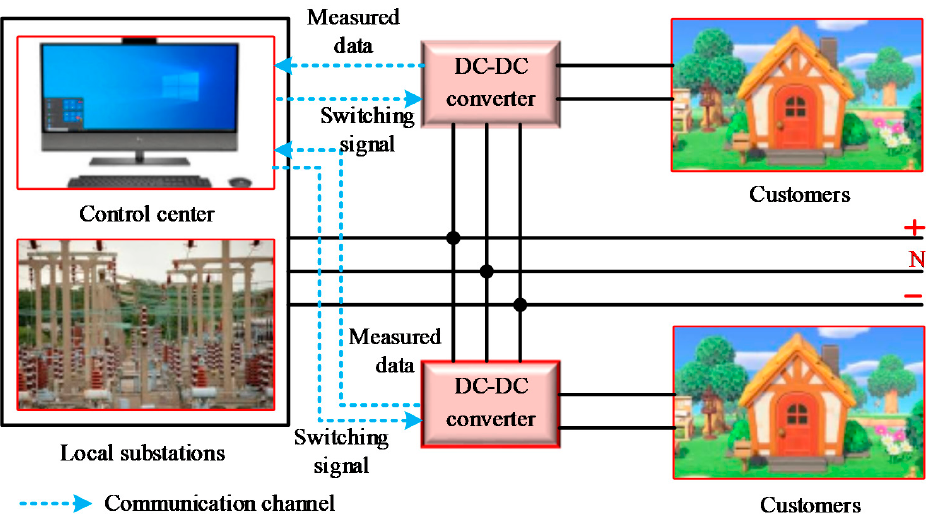
Figure 12. Schematic of the static load transfer switch (SLTS) method [20].